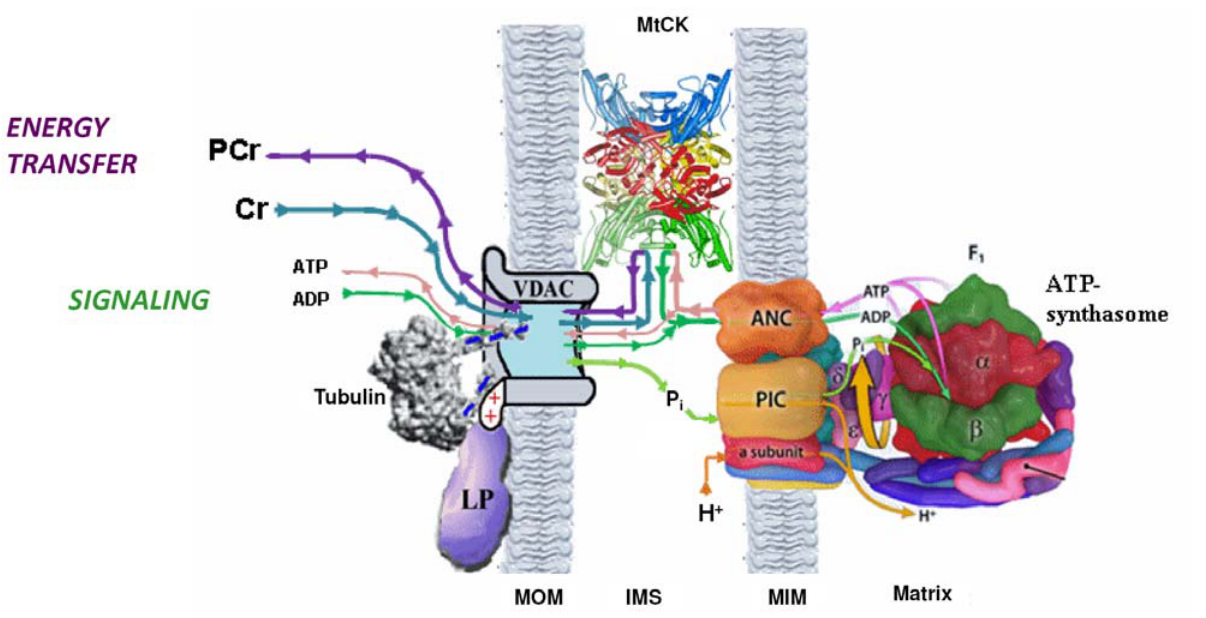
Figure 3. Mitochondrial Interactosome (MI) in cardiac, oxidative skeletal muscle and brain cells. Mitochondrial interactosome consists of ATP Synthasome (formed by ATP synthase, adenine nucleotide carrier (ANC) as proposed by Pedersen [152]), and inorganic phosphate carrier (PIC)), mitochondrial creatine kinase (MtCK) functionally coupled to ATP synthasome and voltage dependent anion channel (VDAC) with regulatory proteins (tubulin and linker proteins (LP)). ATP regenerated by ATP synthase is transferred to MtCK due to its functional coupling with ATP syntasome. MtCK catalyses transfer of phosphate group from ATP to creatine producing phosphocreatine (PCr) which leaves mitochondria as a main energy carrier due to highly selective permeability of VDAC. ADP is returned to and recycled in ATP Synthasome. Small signaling amounts of cytosolic ADP enter the intermembrane space (see the text) and increase the ADP recycling rate within MI maintaining increased production of the PCr. In this way coupled MtCK amplifies cytosolic ADP signal. MOM, mitochondrial outer membrane; MIM, mitochondrial inner membrane; IMS, mitochondrial intermembrane space. Reproduced from [32] with